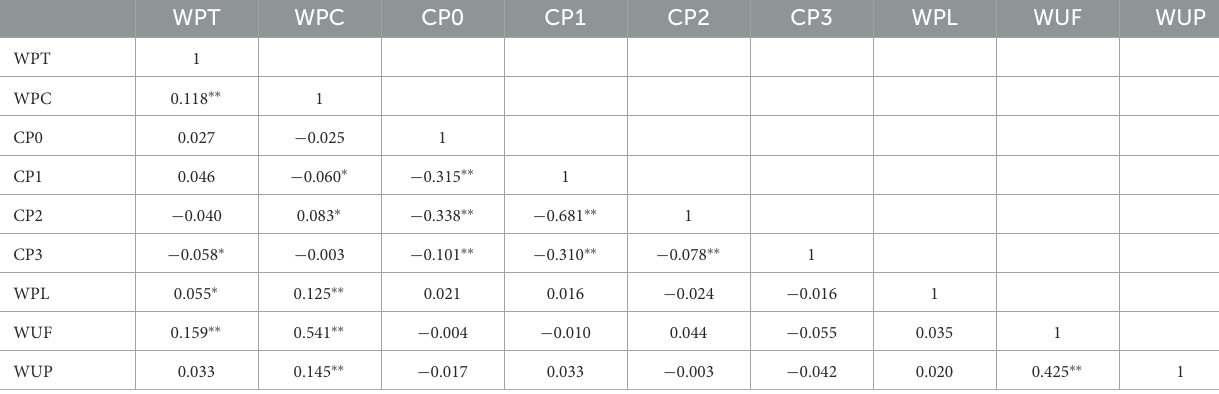
TABLE 6 Pearson correlation coefficient of the event “The Wuhan Red Cross”.